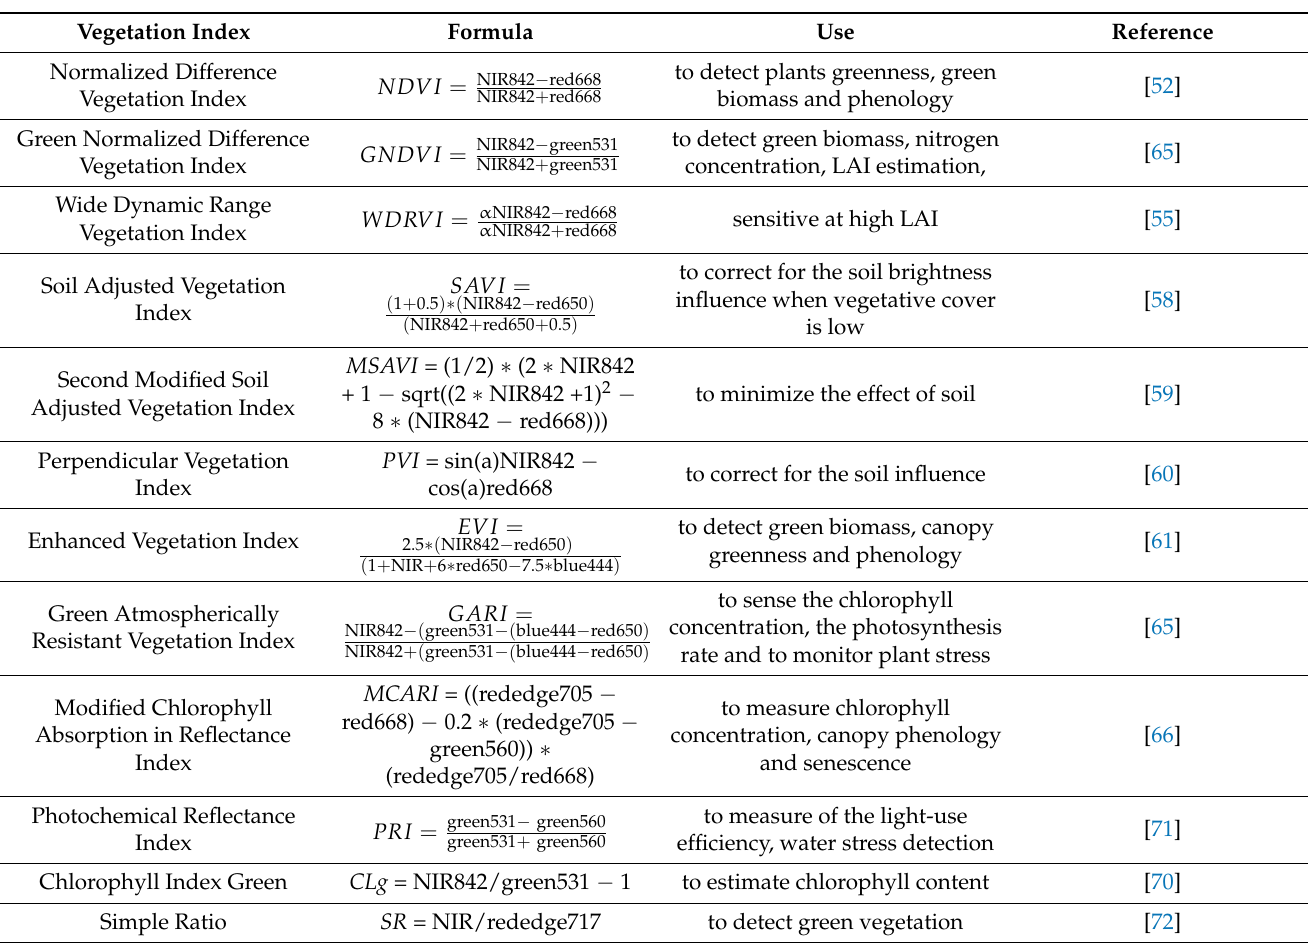
Table 4. List of Vegetation Indices (VIs) derived from the multispectral sensor. Abbreviations besides each band correspond to centre wavelengths in